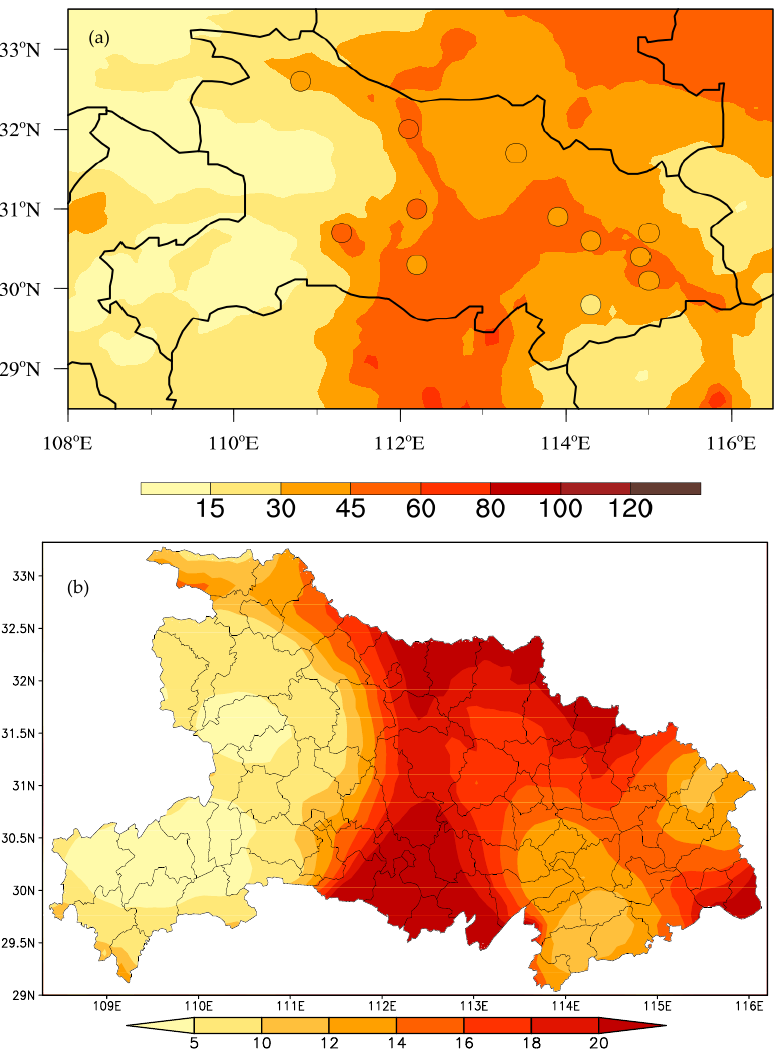
Figure 7. ( a ) Average PM 2.5 concentration (unit: μg/m 3 ) in February 2020 simulated by the Weather Research and Forecasting Model coupled with Chemistry (WRF-Chem) control test (CT, shaded) and observations (dotted) in cities in Hubei; ( b ) concentration (unit: μg/m 3 ) of PM 2.5 pollution in Hubei from external sources simulated by a sensitivity test (ST).